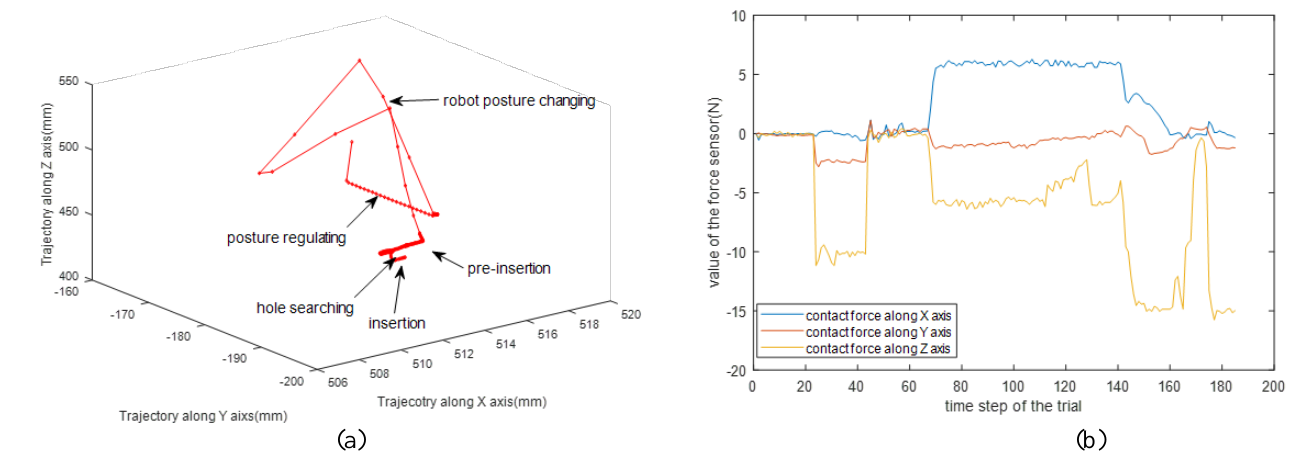
Figure 15. The trajectory and force of key-slot assembly. ( a ) The robot trajectories of the assembly task; ( b ) the force value in different time step.